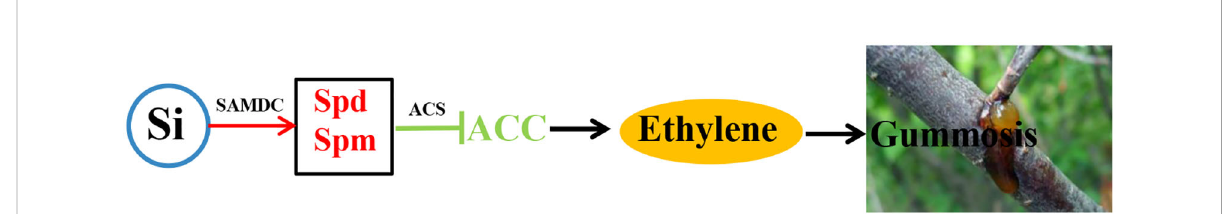
FIGURE 6 Silicon-mediated polyamine inhibition of ethylene synthesis to inhibit gummosis. Target induction is depicted by solid arrows, whereas inhibition is depicted by blocked lines. Red indicates upregulation, and green indicates downregulation. (Si: silicon; SAMDC: S-adenosine methionine decarboxylase; ACS: ACC synthase; Spd: spermidine; Spm: